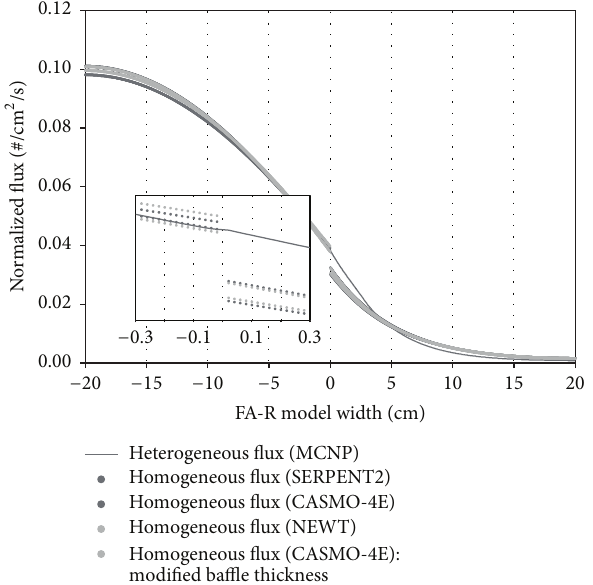
Figure 11: The fast flux distribution and detail view at interface for FA-RB model.